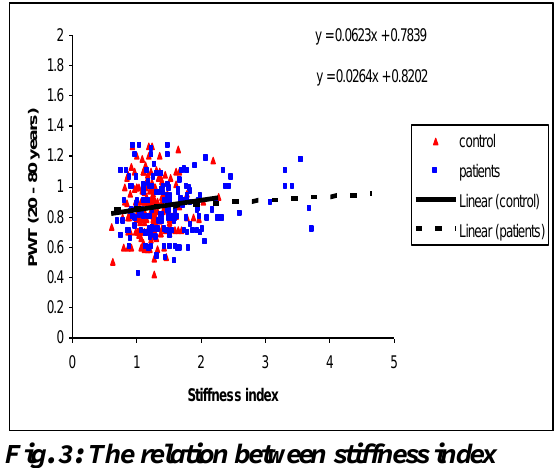
Fig. 3: The relation between stiffness index and posterior wall(PWT).